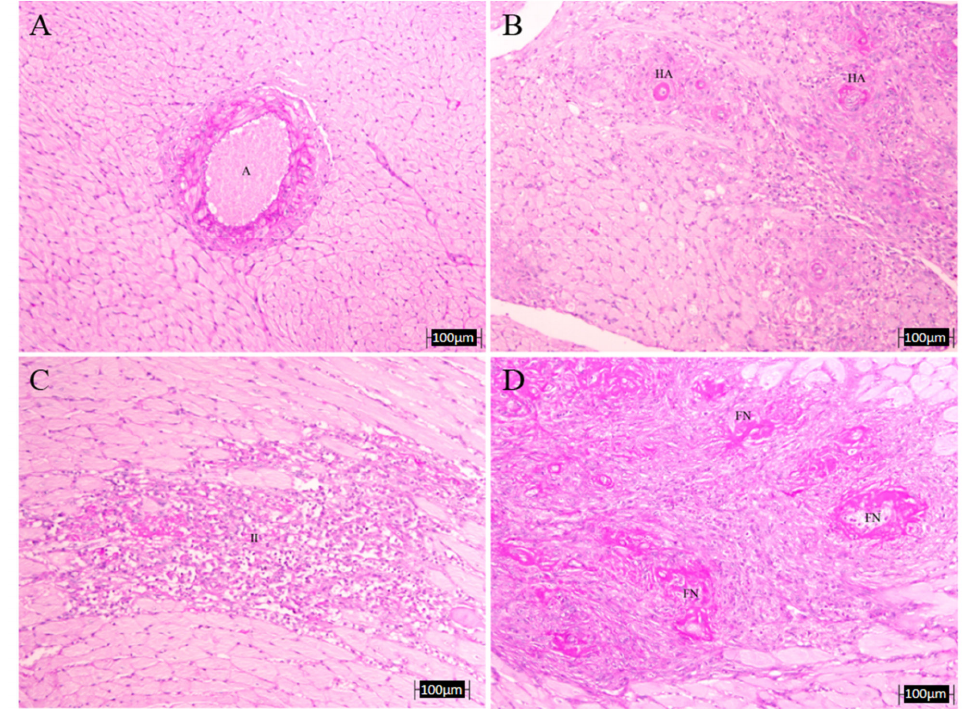
Figure 6. Representative microphotographs of heart lesions. Upper left: intramyocardial artery ( A ) of a control non-treated rat (no morphological alterations, PAS, 10 × ); ( B ) hyaline arteriopathy (HA) in a coronary artery of L-NAME-treated rat (PAS, 10 × ); ( C ) intense vascular damage with inflammatory infiltrate (II) and myocardiocytes lesions in a L-NAME-treated rat heart (PAS, 10 × ); ( D ) fibrinoid necrosis (FN) in a coronary artery of L-NAME-treated rat (PAS, 10 ×